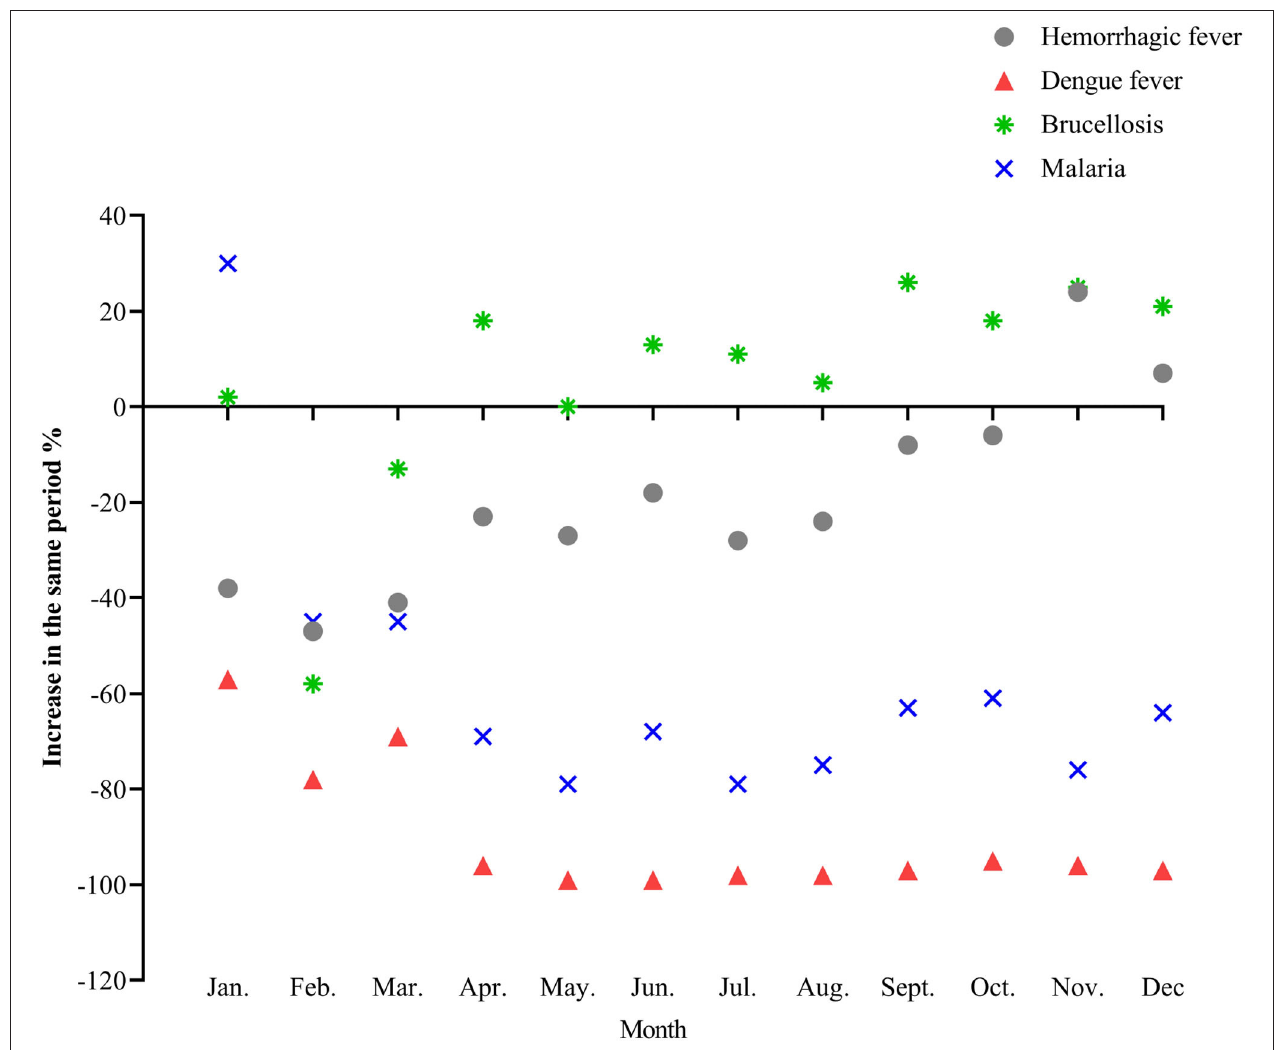
FIGURE 6 | The incidence trend of natural foci and insect-borne diseases in